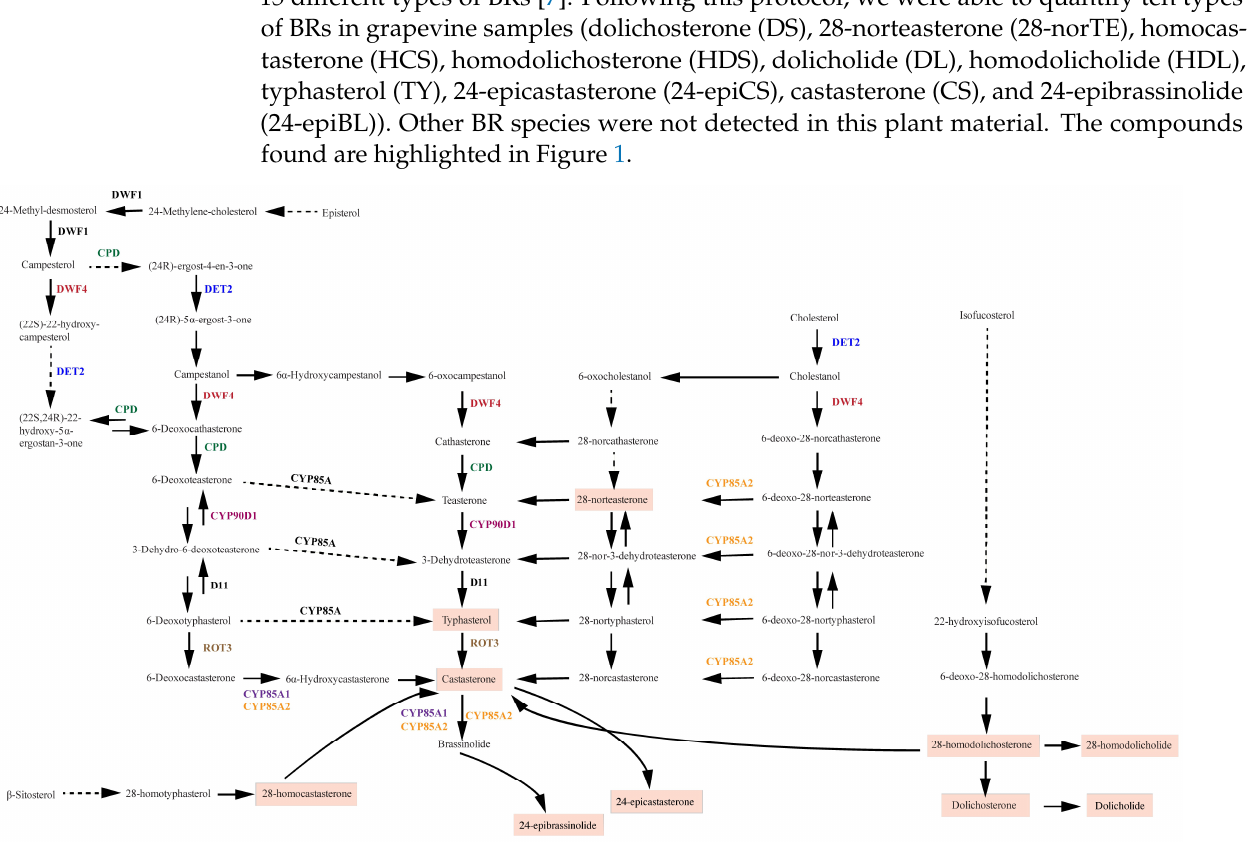
Figure 1. Brassinosteroid biosynthesis routes. The different routes of biosynthesis of brassinosteroids are depicted. Dashed lines indicate multiple enzymatic steps. Compounds detected in this work are highlighted in orange. Diagram based on [33–35,51–53].